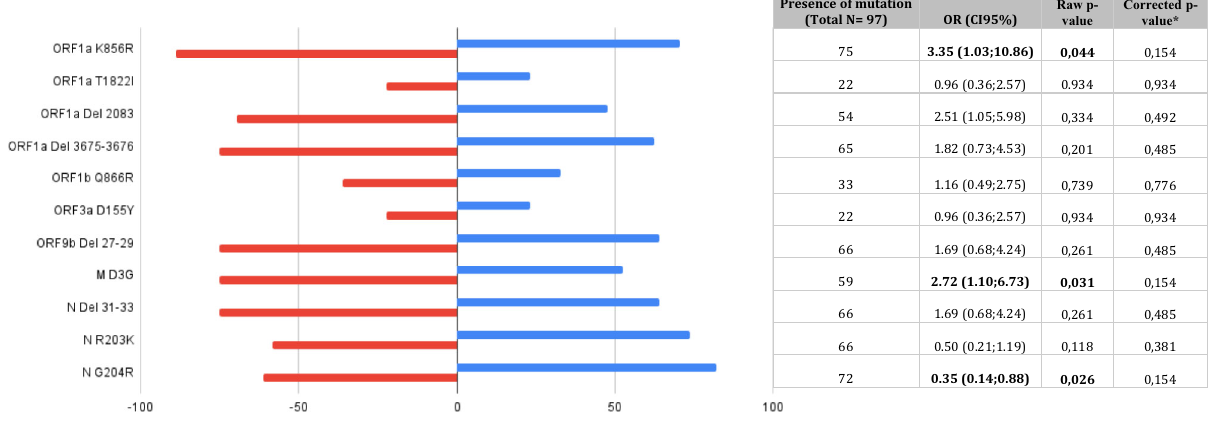
Fig. 4 | Relationship between SARS-CoV-2 mutations/deletions and day-28 mortality in patients infected with variant Omicron. Over the full-length viral genomes of 97 Omicron sample-related patients, we investigated amino acid modi fi cations(substitutionsordeletions)outsideSpikeproteinfoundinatleast20 viral genomes of patients infected by Omicron ( n =11 positions) and analyzed the relationship between these mutations and day-28 mortality in univariable analysis. Two amino acid substitutions (ORF1a-K856R=NSP3 K38R and M-D3G) were